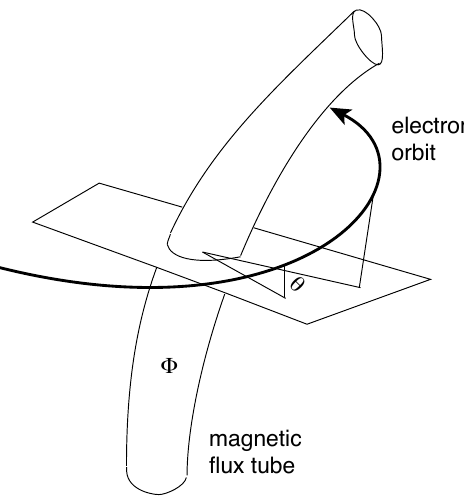
Fig. 1. Geometry of the Aharonov-Bohm effect. The electron (any charged particle) moves at some angle θ around a magnetic flux tube containing some magnetic flux 8 . Since outside the flux tube the magnetic flux vanishes, the vector potential in this region re- duces to a scalar potential which can be gauged away. However, quantum mechanically its effect is remarkable, forcing the flux to be